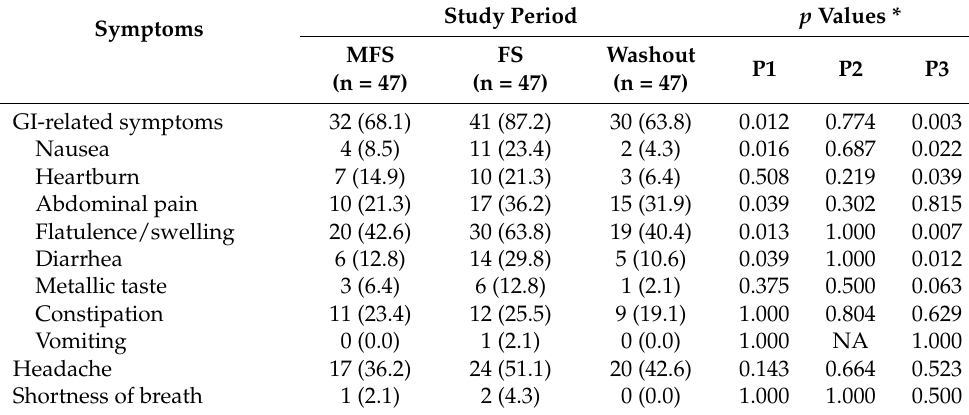
Table 3. Number and percentages of participants who experienced GI-related symptoms, headache, and shortness of